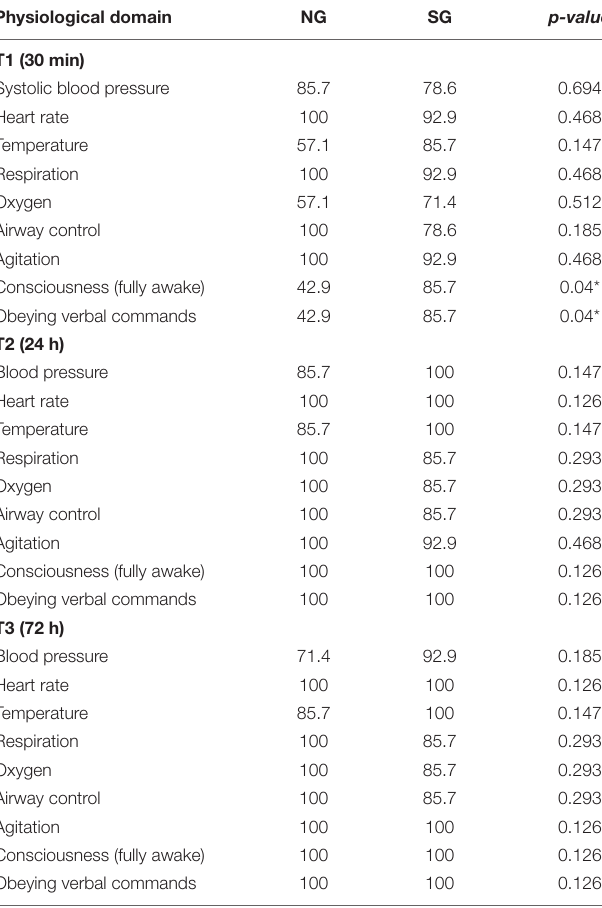
TABLE 1 | Baseline characteristics of patients with anesthesia and surgery-related data. NG SG